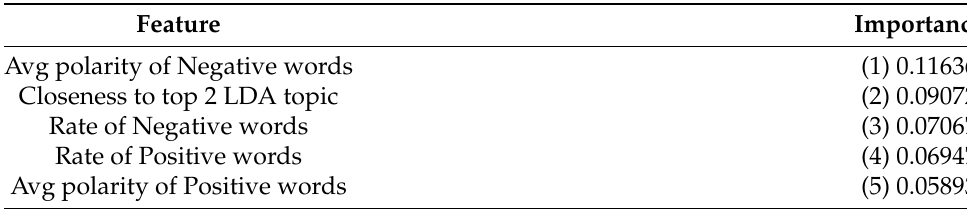
Table 7. The five most important features in RF Model.